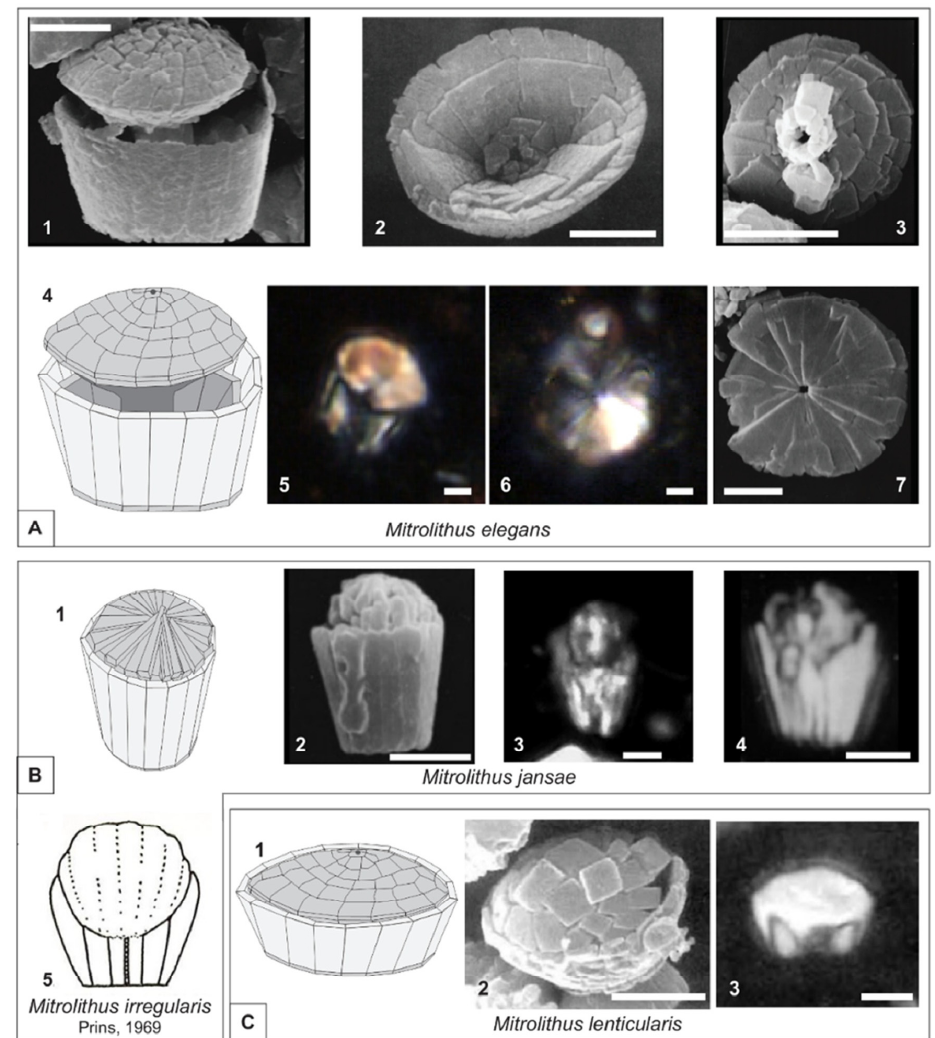
Figure 3. The three species of Mitrolithus known nowadays, as represented in the literature, with schematic drawings illustrating their main morphological features. The white scale bar is 2 μ m. ( A ) Mitrolithus elegans : 1. SEM image of a side-view coccolith, modified after Bown [8] (plate 3 figure 7); 2. SEM image of a distal-view coccolith without the spine (modified after Bown [40], plate 3 figure 1); 3. SEM image of an isolated spine, proximal view (the broken spine is still visible), modified after Bown [8] (plate 3 figure 10); 4. Sketch redrawn from the SEM image in 1. 5. A side-view specimen recorded in the Kermanshah area (sample J.0–28) under optical microscope, crossed polars. 6. An isolated spine in distal view recorded in the Kermanshah area (sample J.0–28) under optical microscope, crossed polars. 7. SEM image of an isolated spine, distal view, after Bown [8] (plate 3 figure 12). ( B ) Mitrolithus jansae : 1. Sketch redrawn from SEM images; 2. SEM image of a side-view coccolith, modified after Bown and Cooper [41] (plate 1 figure 11); 3. A side-view specimen under optical microscope, crossed polars modified after Menini et al. [42] (plate 1 figure 14). The calcite laths forming the distal shield appear light grey, while the highly birefringent elements inside these laths, as high as two-thirds of the rim, likely correspond to the proximal shield elements, which are rarely visible due to the bulky structure of the coccolith; 4. A side-view specimen under optical microscope, crossed polars, modified after Bown and Cooper [33] (plate 1 figure 16); 5. The sketch of M. irregularis figured as nomen nudum by Prins [37] and interpreted as it was derived from M. elegans . ( C ) Mitrolithus lenticularis : 1. Sketch redrawn from SEM images; 2. SEM image of a side/distal-view coccolith (holotype), modified after Bown [8] (plate 4 figure 7); 3. A side-view specimen under optical microscope, crossed polars modified after Bown [8] (plate 12 figure